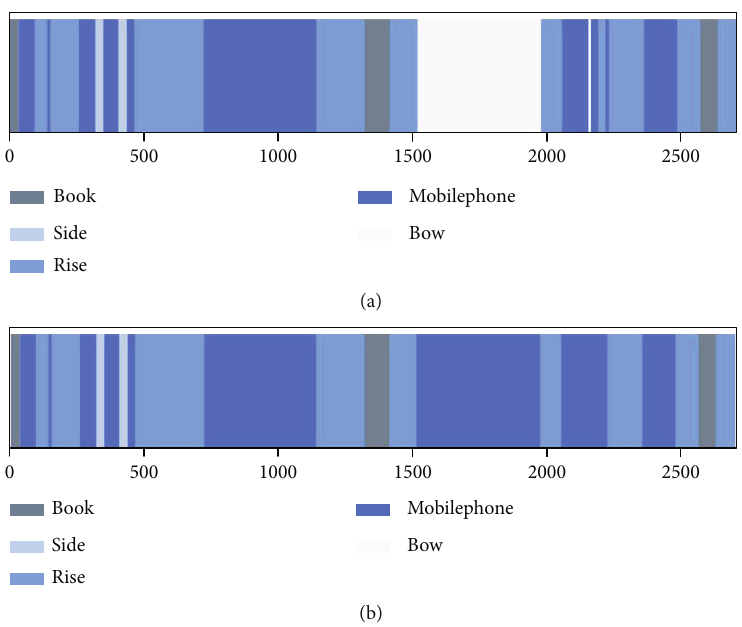
Figure 4: The preface of the student class behavior before and after the correction. Table 3: Comparison results of the two methods.